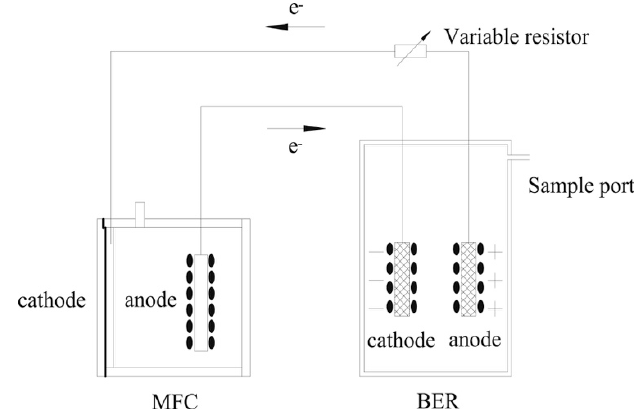
Figure 5. Experimental apparatus employed by Hao et al. [141]. Reprinted from Hao et al. [141] with